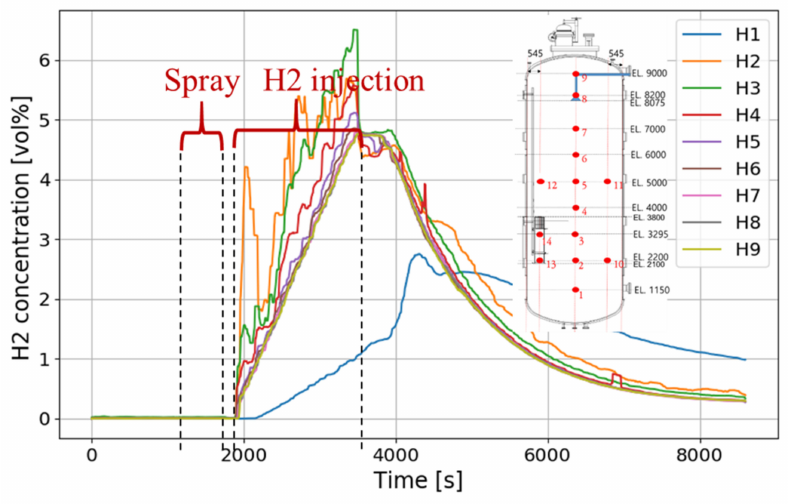
Figure 14. Time variations in the hydrogen concentrations during the SSP3 test.